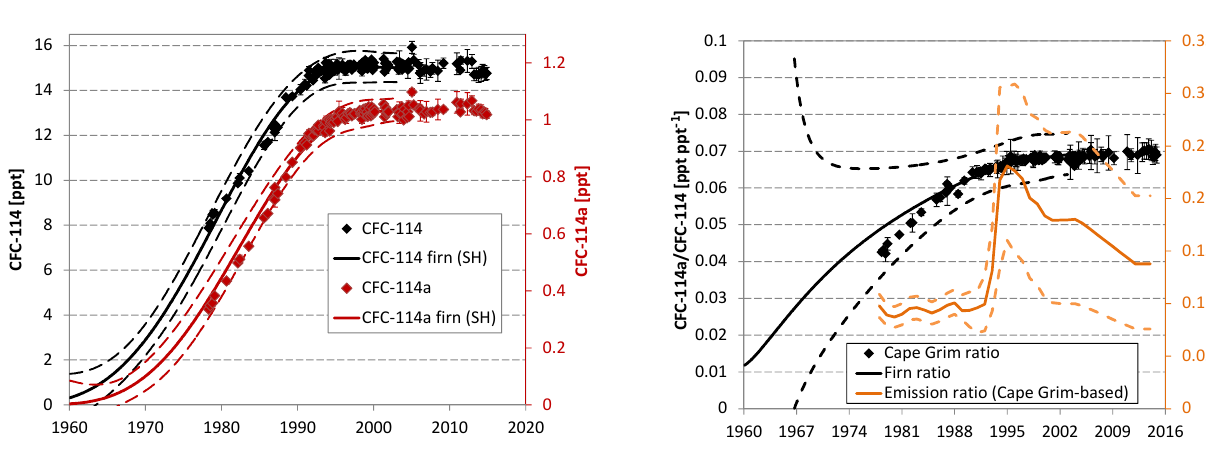
Figure 2. CFC-114a / CFC-114 ratio of mixing ratios at Cape Grim (left axis, black diamonds) and derived from Antarctic firn (left axis, black line), as well as the ratio of their emissions derived from these observations (right axis, orange line). Uncertainties of those ratios are calculated from the uncertainties of mixing ratios (Fig. 1) and emissions (Fig. 3) and using the equation for combining errors in